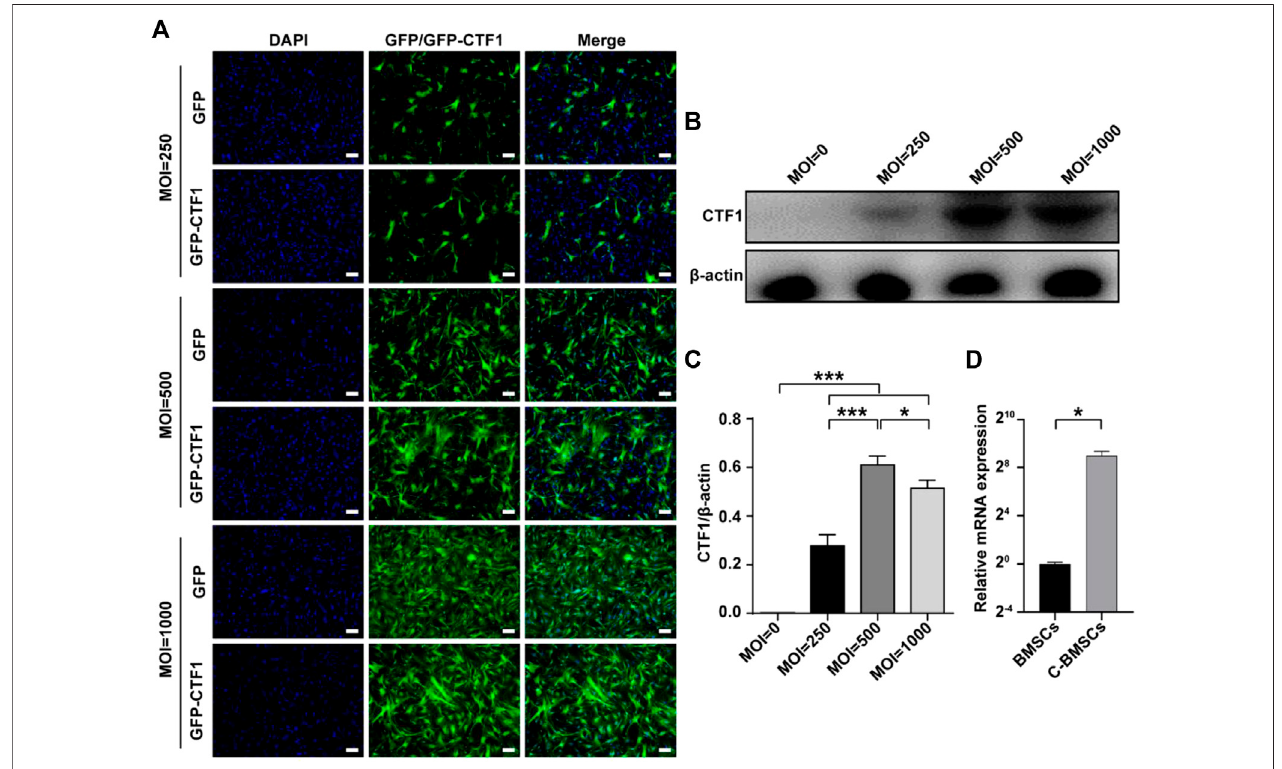
FIGURE 2 | Stable adenoviral overexpression of CTF1 in BMSCs. (A) Transduction ratios for cells overexpressing CTF1 or GFP (as a control). (B – D) Western blotting ( n = 3, independent biological replicates) and qPCR ( n = 3, technical replicates) were used to con fi rm the increased expression of CTF1 in C-BMSCs relative